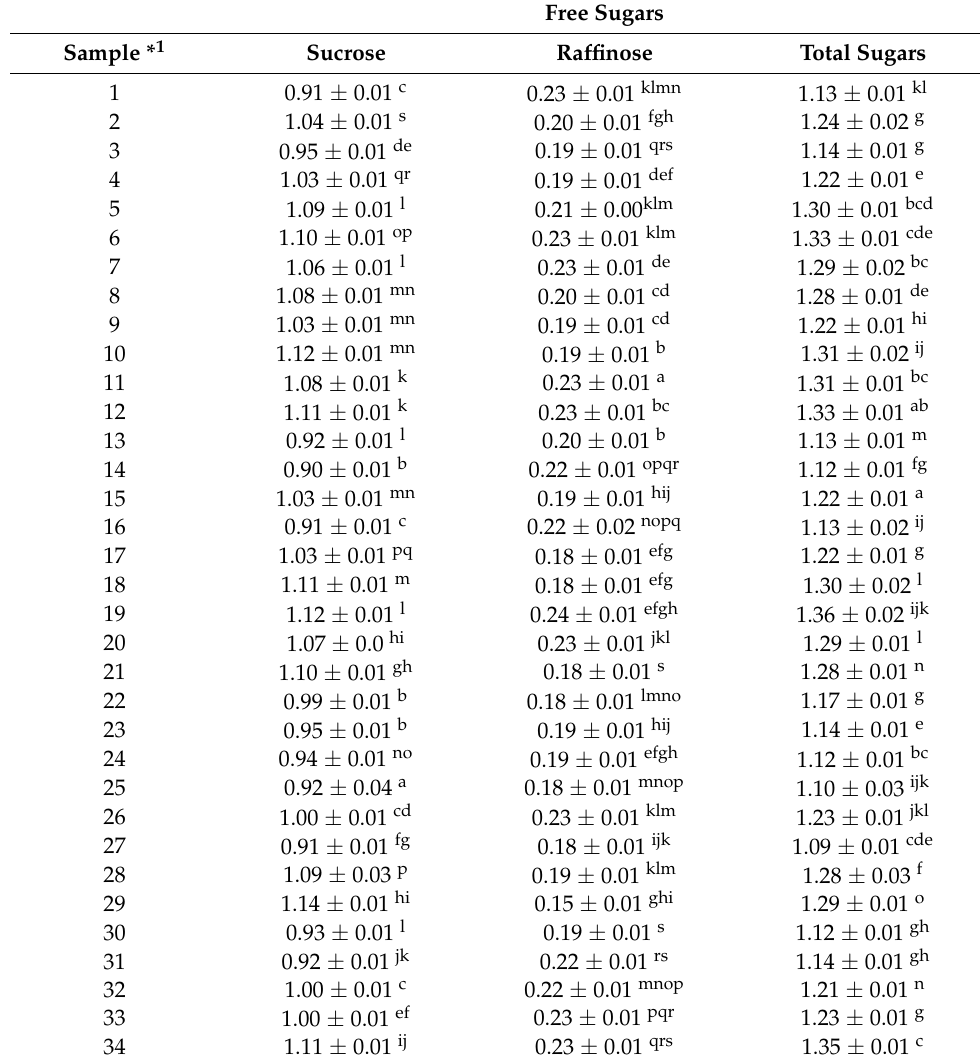
Table 2. Composition regarding sugars (g/100 g fw) of the studied Pardina lentil “Lenteja de Tierra de Campos” (mean ± SD, n =